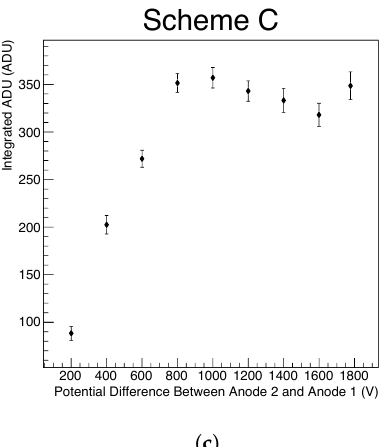
Figure 15. Light gain measurements of integrated ADU from 241 Am source ( a ) vs. anode 1 voltage where the voltage difference between anode 1 and 2 (anode 2 and 3) is kept constant at ∆ V a 12 = ∆ V = 1200V, ( b ) vs. voltage potential difference between anode 2 and anode 3 whilst the voltage a 23 difference between anodes 1 and 2 is maintained at 1200V, and ( c ) vs. potential difference between anodes 1 and 2 whilst the potential difference between anode 2 and 3 is maintained at 1200V. All of the measurements have been performed in the same fill of pure argon at 3bar absolute